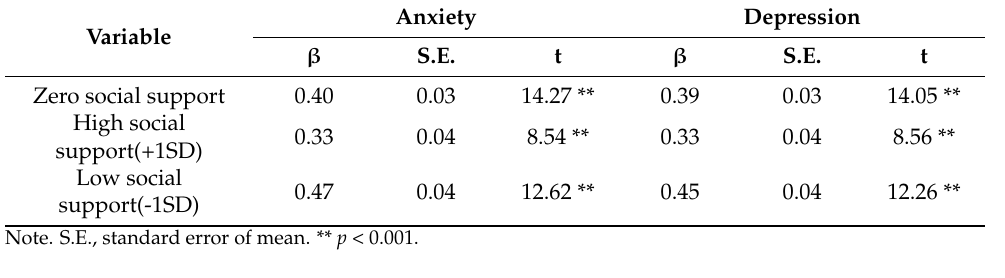
Table 5. Moderation Effect of Social Support.